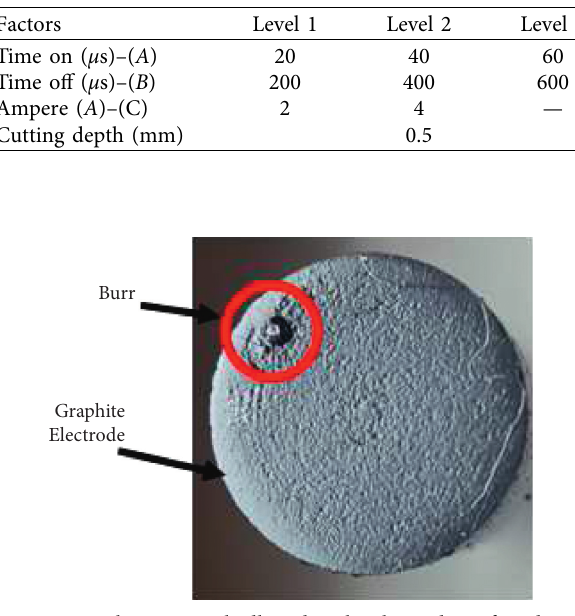
Figure 2: Molten material adhered to the electrode surface during the